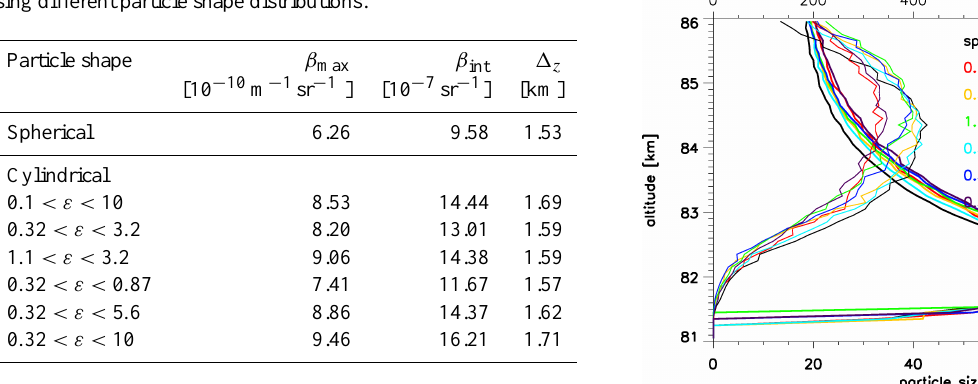
Table 1. Mean values for MIMAS NLC brightness north of 60 ◦ N using different particle shape distributions.